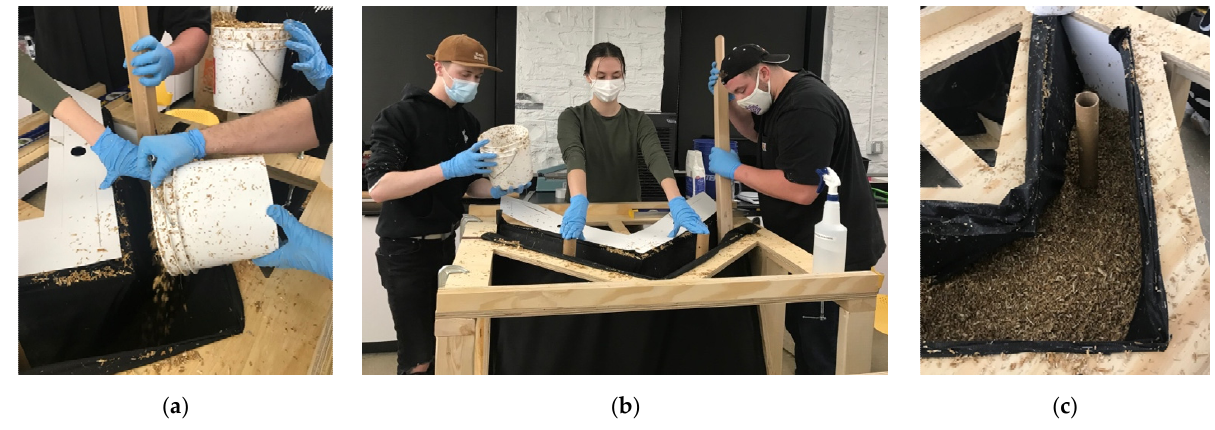
Figure 12. Packing the fabric formwork apparatus with living myco-materials: ( a ) loose inoculated substrate was poured into the apparatus; ( b ) material was compressed into the form while minding the cardboard conduits; ( c ) apparatus almost full of inoculated substrate. Photos by the author.